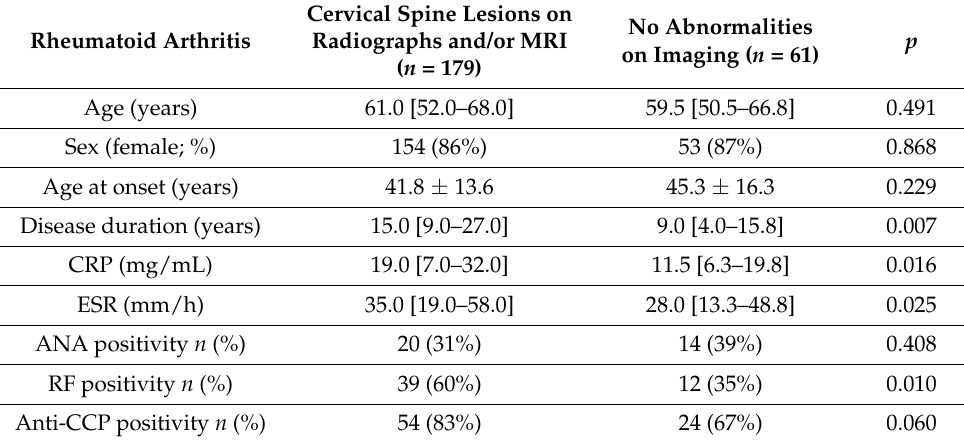
Table 2. Characteristics of RA group. ANA: antinuclear antibodies, CCP: cyclic citrullinated peptides, CRP: C-reactive protein, ERP: erythrocyte sedimentation rate, MRI: magnetic resonance imaging, RA: rheumatoid arthritis, RF: rheumatoid